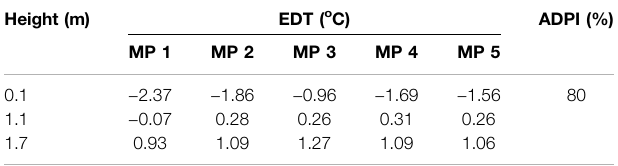
TABLE 2 | EDT at different measuring points.